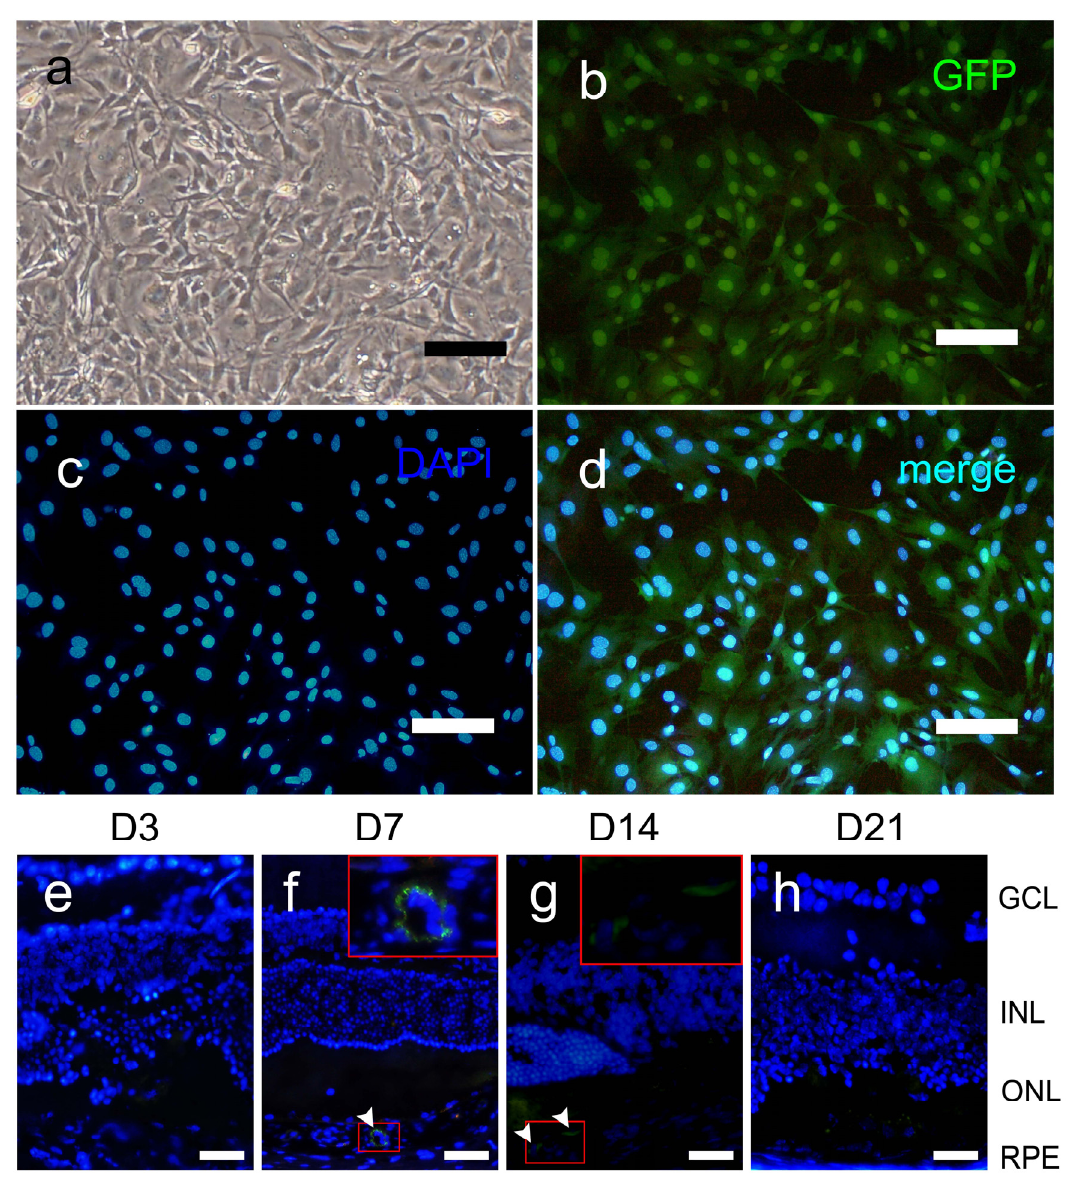
Figure 1. Green fluorescent protein (GFP) expression of cultivated GFP-labeled mesenchymal stem cells (MSCs) and their trace in the retina. ( a ) Fibroblastic phenotype of Passage 15 MSCs under an inverted phase contrast microscope; ( b ) Green fluorescence of GFP in the cytoplasm under a fluorescence microscope; ( c ) Blue fluorescence of 4',6- diamidino-2-phenylindole (DAPI) in the nucleus; ( d ) Merged image of ( b ) and ( c ); Frozen sections of the eyes were observed under a fluorescence microscope at each time point ( e – h ); Green GFP+ MSCs are indicated by white arrowheads ( f , g ). Scale bars: 50 μ